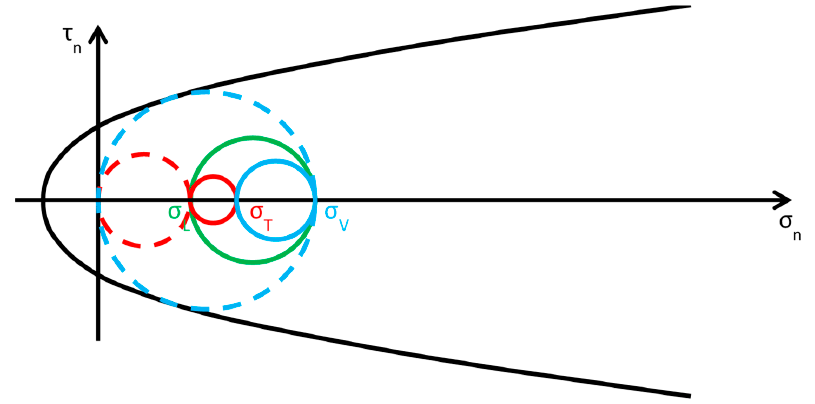
Figure 16. Stress analysis in the plane of Mohr/Coulomb after retrofitting, for 0 < σ T ≤ σ L (Mohr’s circles before retrofitting in dashed lines, for comparison).